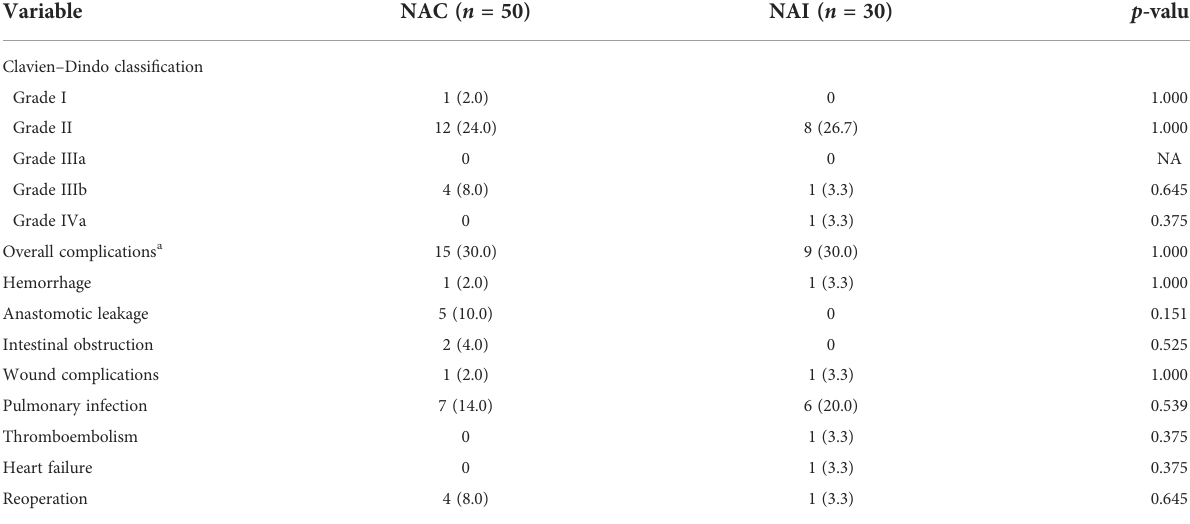
TABLE 4 Postoperative